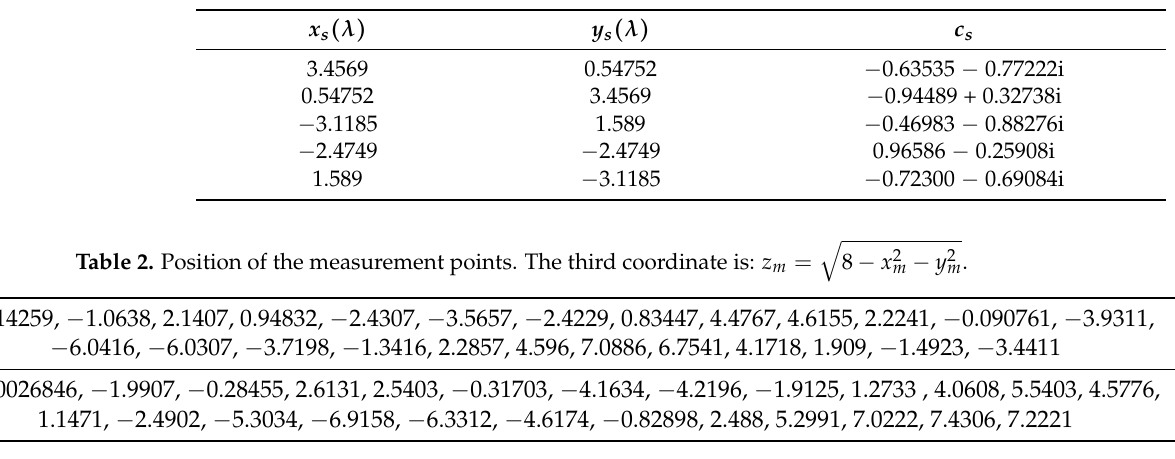
Table 1. Position and relative excitation of the 5 unknown isotropic sources.